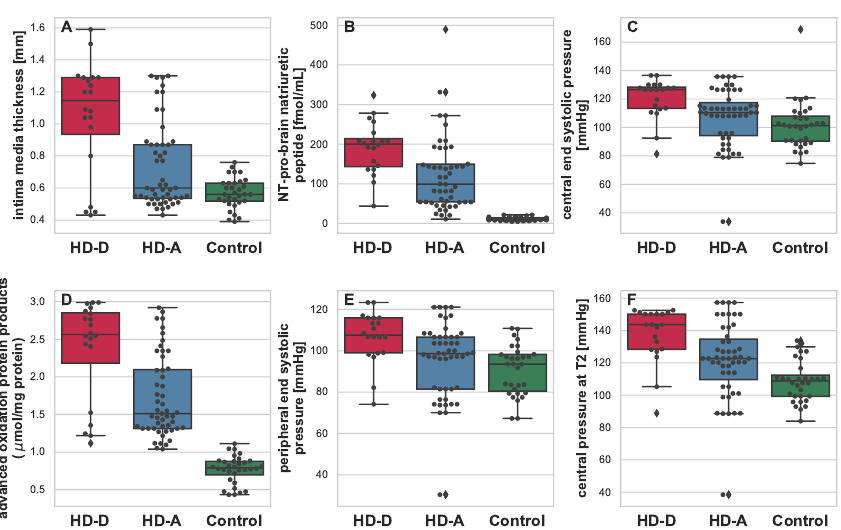
Figure 3. Boxplot depicting differences between HD-D (red), HD-A (blue), and Control (green) for the chosen variables: intima media thickness ( A ), NT-pro-brain natriuretic peptide ( B ), central end systolic pressure ( C ), advanced oxidation protein products ( D ), peripheral end systolic pressure ( E ), and central pressure at T2 ( F ). Additional swarmplot was overlaid onto the original plot in order to mark the obtained measurements for each of the patients (dots). Outlier values are represented by